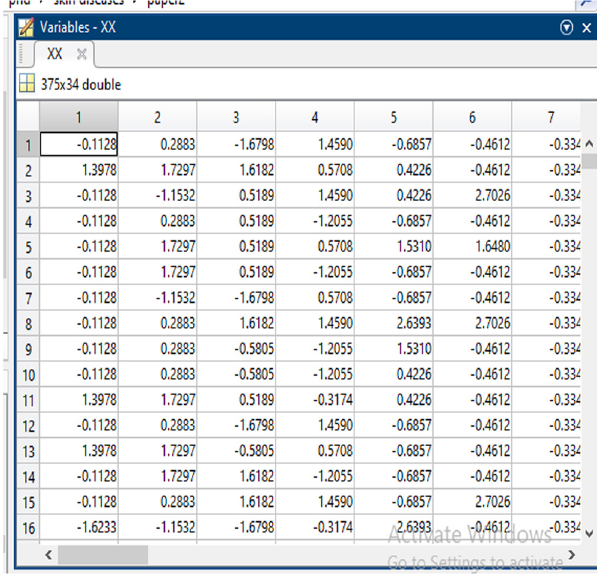
Figure 4: Pre - process output.